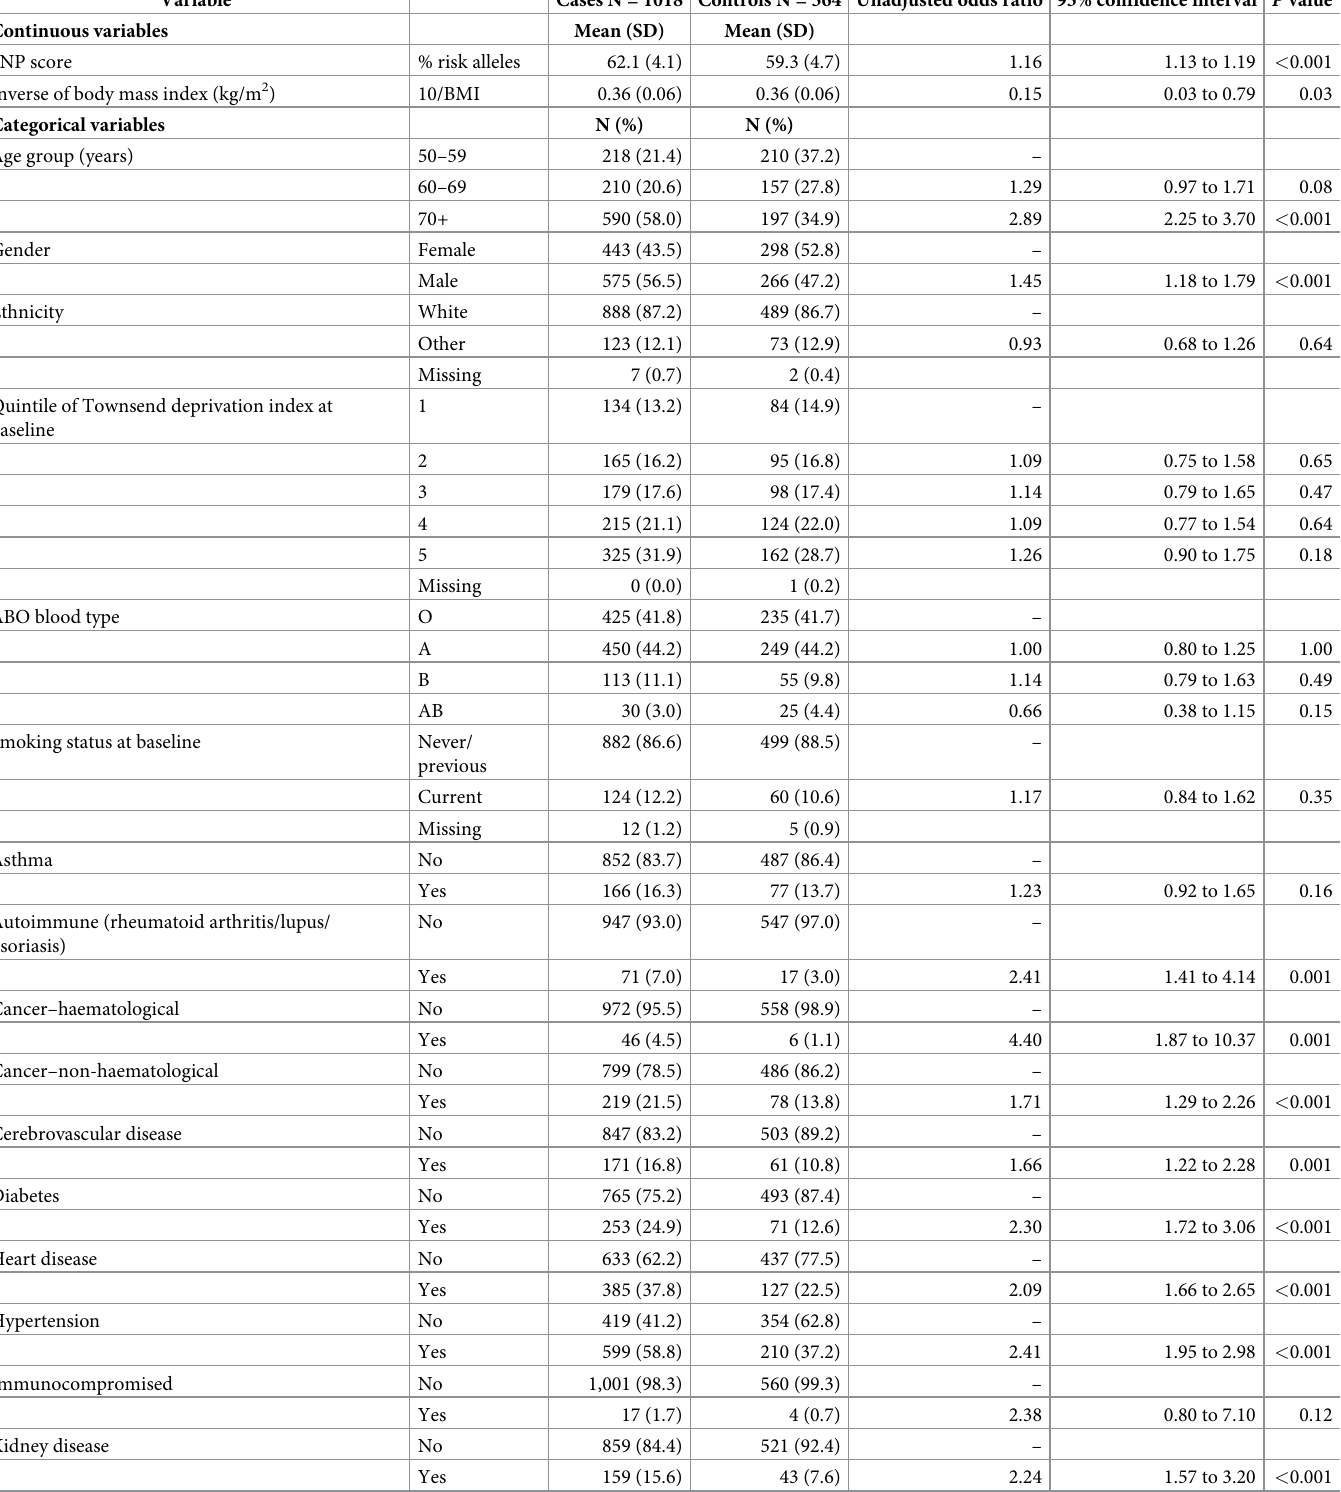
Table 1. Characteristics of cases and controls and unadjusted odds ratios for risk of severe COVID-19.